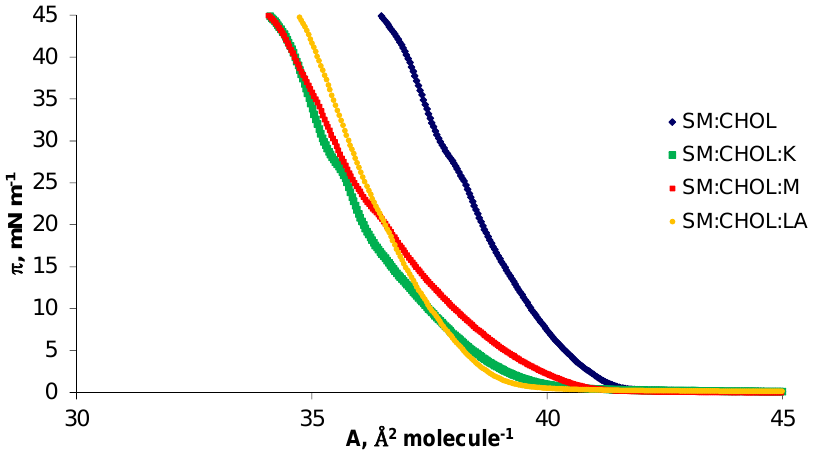
Figure 2. Surface pressure-area ( π –A) isotherms of DPPC:CHOL, DPPC:CHOL:K, DPPC:CHOL:M, DPPC:CHOL:LA systems at a temperature of 22 ◦ C.